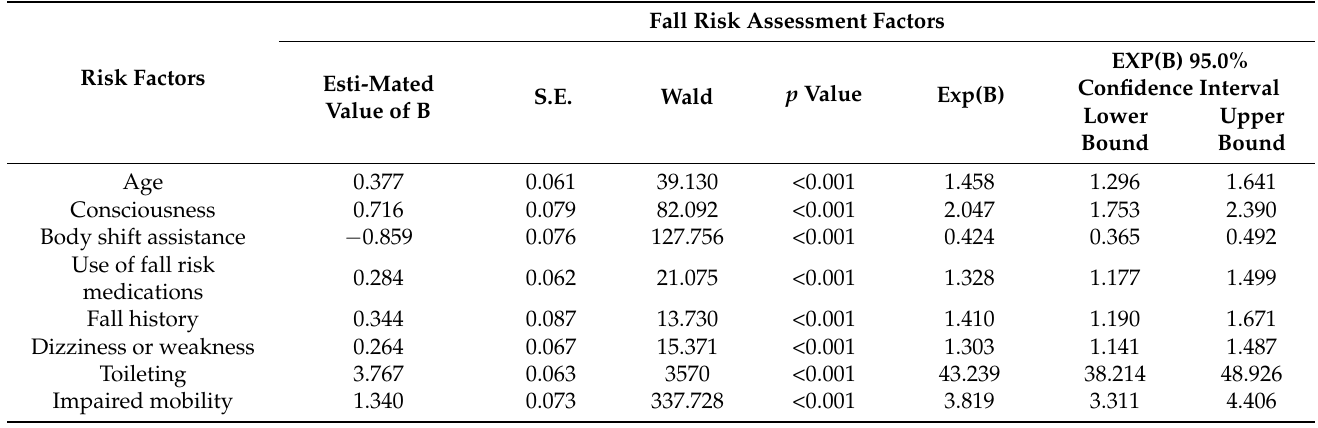
Table 1. Logistic Regression Analysis of Fall Risk Assessment